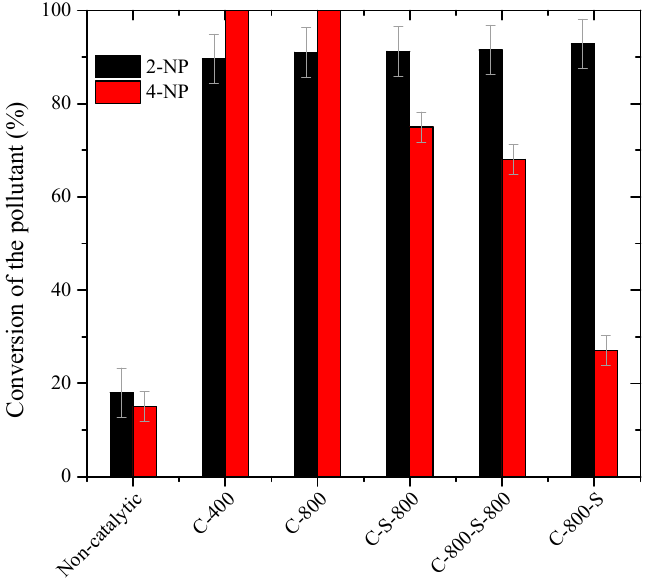
Figure 6. Conversion after 24 h of 2 ‐ nitrophenol and 4 ‐ nitrophenol by CWPO using as catalysts the